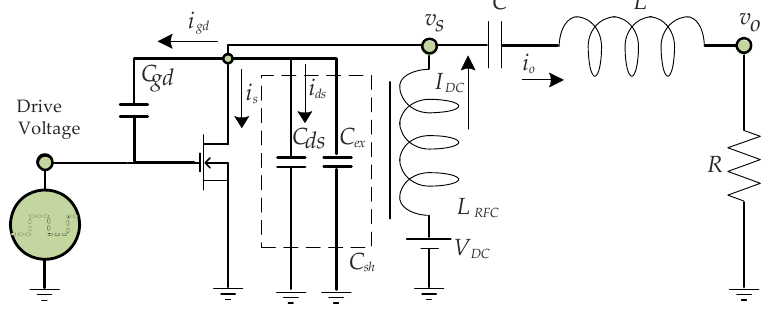
Figure 2. The considered circuit to design the Class ‐ E PA.